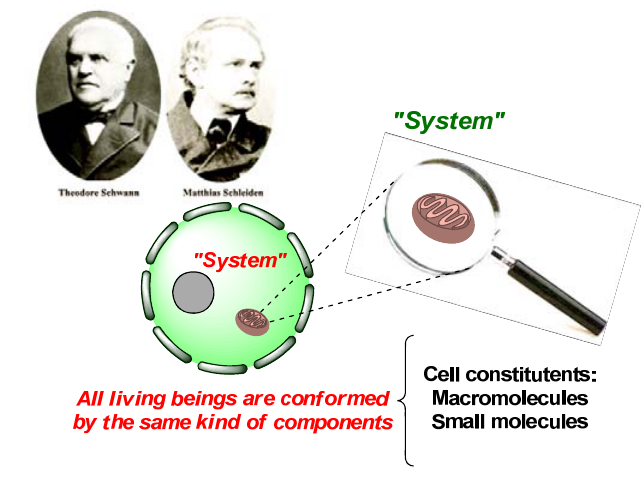
Figure 1. Cellular objects of chemical